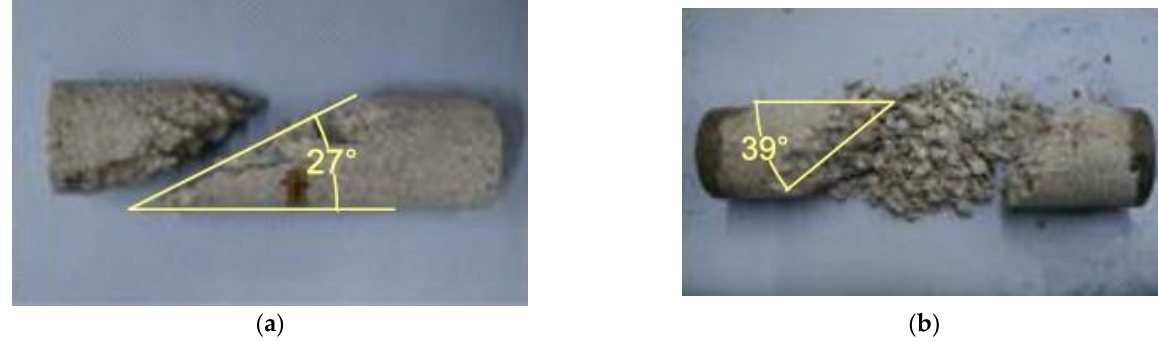
Figure 7. Typical fracture pattern; ( a ) test series P0 and PE; ( b ) test series A10 and A20.